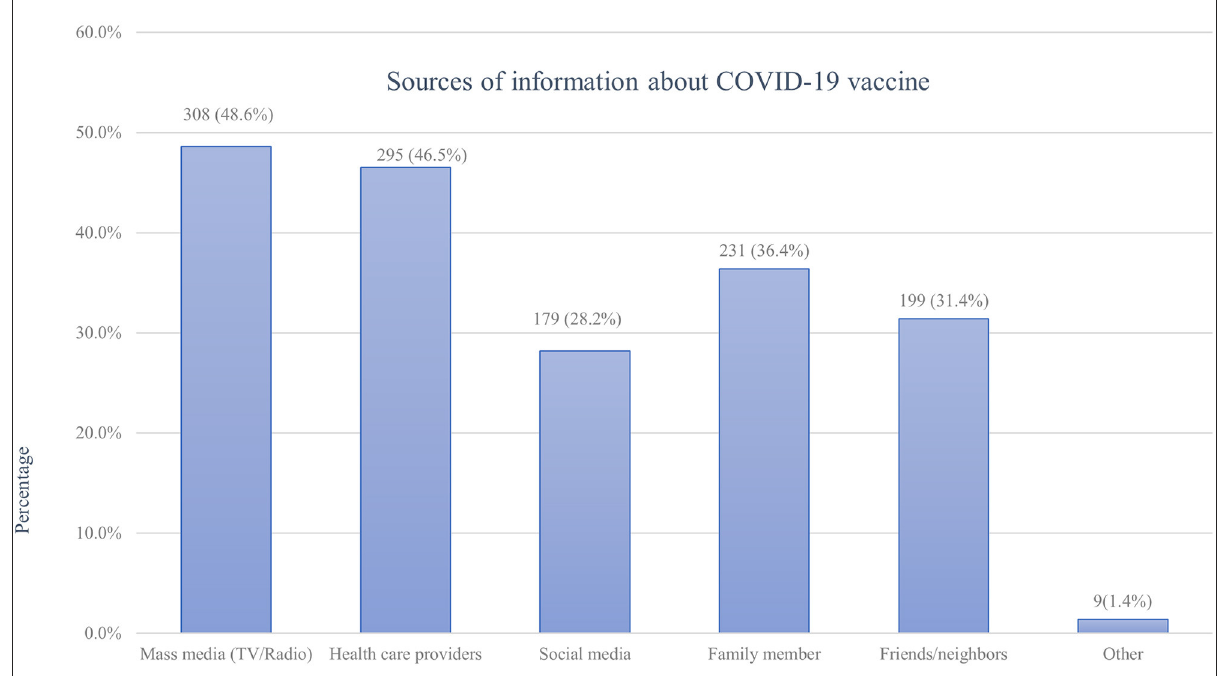
FIGURE1 Sources of information about the COVID-19 vaccine among pregnant women attending antenatal care in Debre Tabor public health institutions, Northwest Ethiopia, 2022.